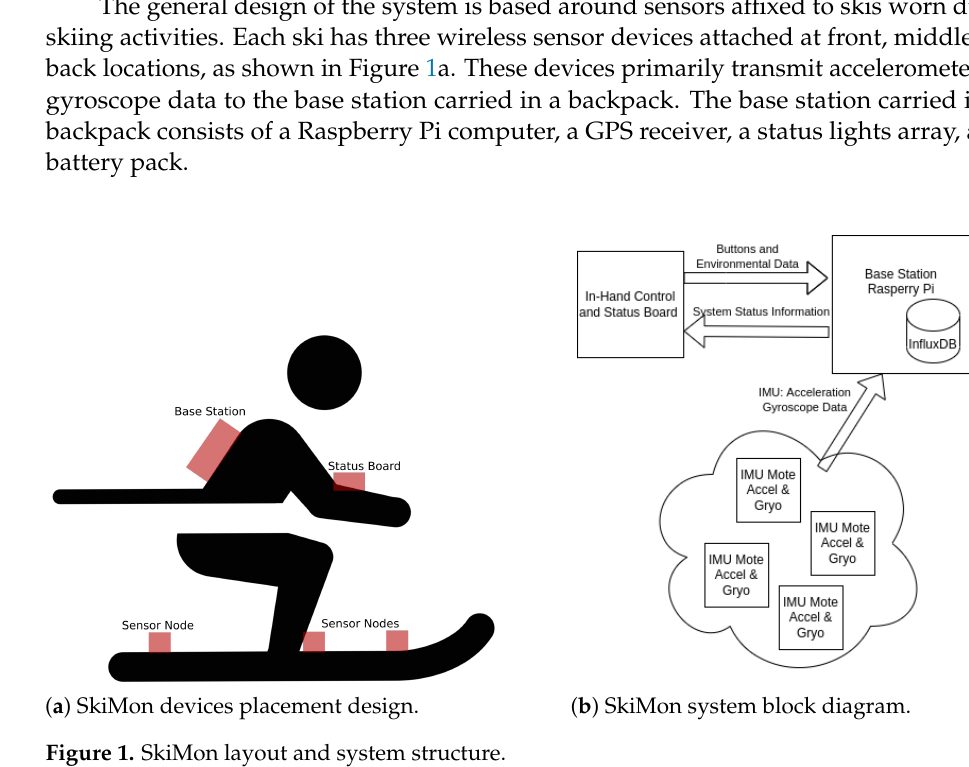
Figure 1. SkiMon layout and system